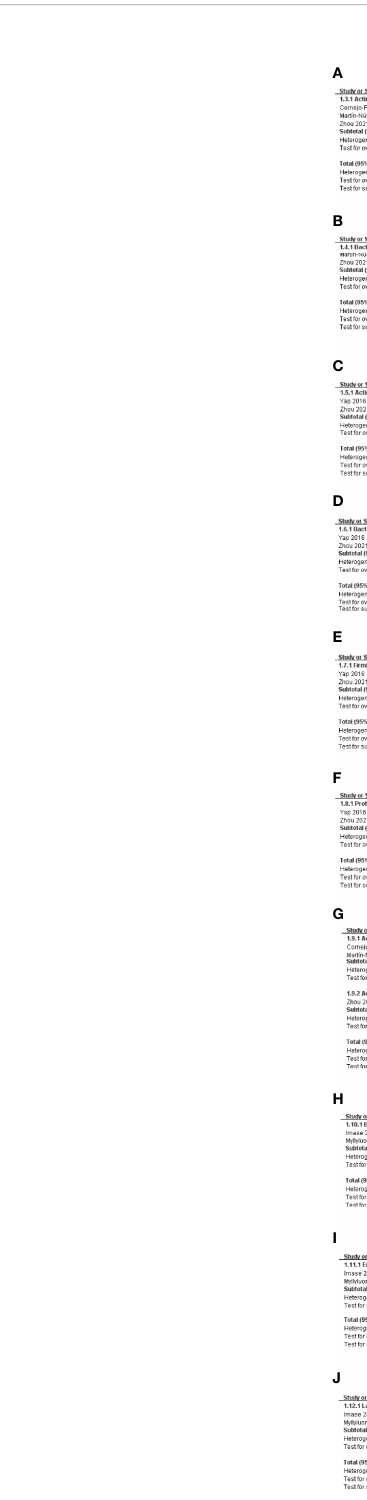
FIGURE 3 Follow-up results after Metronidazole-free triple therapy of H. pylori. (A, B) At the phylum level, changes in gut microbiota abundance (%) at 1 – 3 months after eradication treatment follow-up. (C – F) At the phylum level, changes in gut microbiota abundance (%) more than 6 months after eradication treatment follow-up. (G) At the phylum level, changes in gut microbiota abundance (%) between adults and children at age-based subgroup analysis. (H – J) At the family and genus levels, changes in the number (CFU/g) of gut microbiota within 7 days after eradication treatment